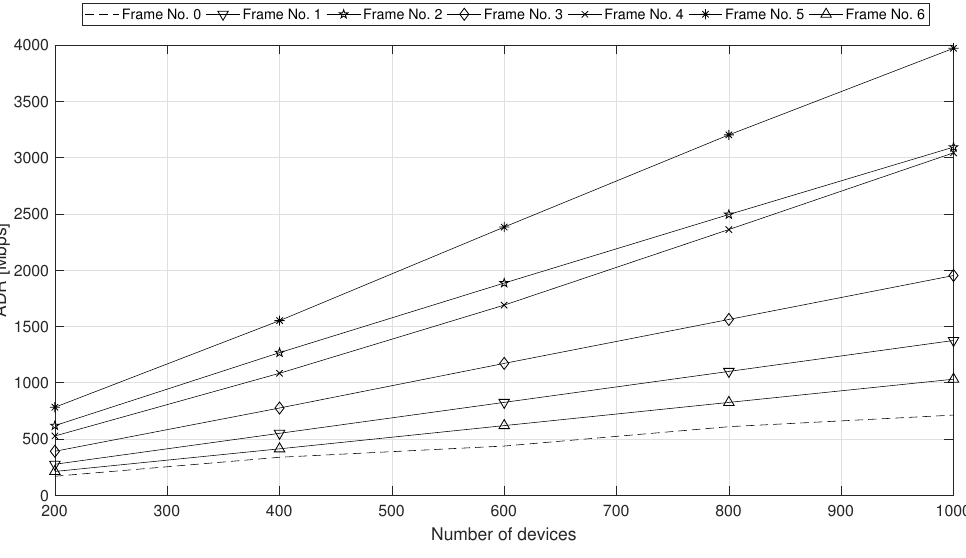
Figure 7. ADR under increasing number of multicast MTC